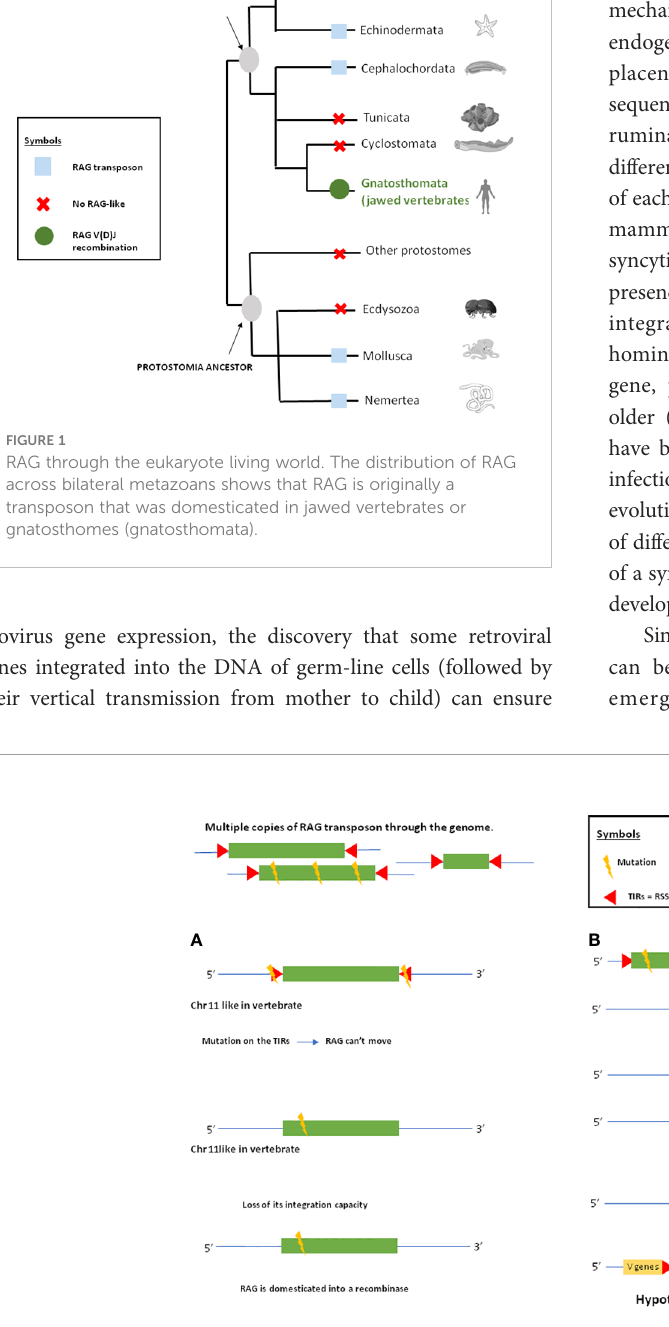
FIGURE 2 RAG domestication and establishment of the ancestral immunoglobulin cluster. The following evolutionary scenario is assumed: there are several copies of the RAG transposon in the genome. Some of these copies are mutated. In (A) , a copy of the RAG transposon is inserted into a chromosome that will later become chromosome 11 in humans where the RAG recombinase is located. This copy of the transposon will be mutated at the level of its TIRs, which will prevent it from jumping elsewhere in the genome. Another mutation within the transposon sequence will cause it to lose its ability to integrate. Thus, the RAG transposon will be domesticated into a recombinase. In (B) , a mutated copy of the RAG transposon will insert itself into an ancestral immunoglobulin. This copy is so mutated that the transposon sequence is eliminated by genetic drift, leaving only the TIRs in the ancestral immunoglobulin gene. After cis-duplication, the IG cluster is established. Thus, in jawed vertebrates, domesticated RAG will act in trans by recognizing TIRs that have become RSSs allowing it to rearrange the V,D and J gene segments.